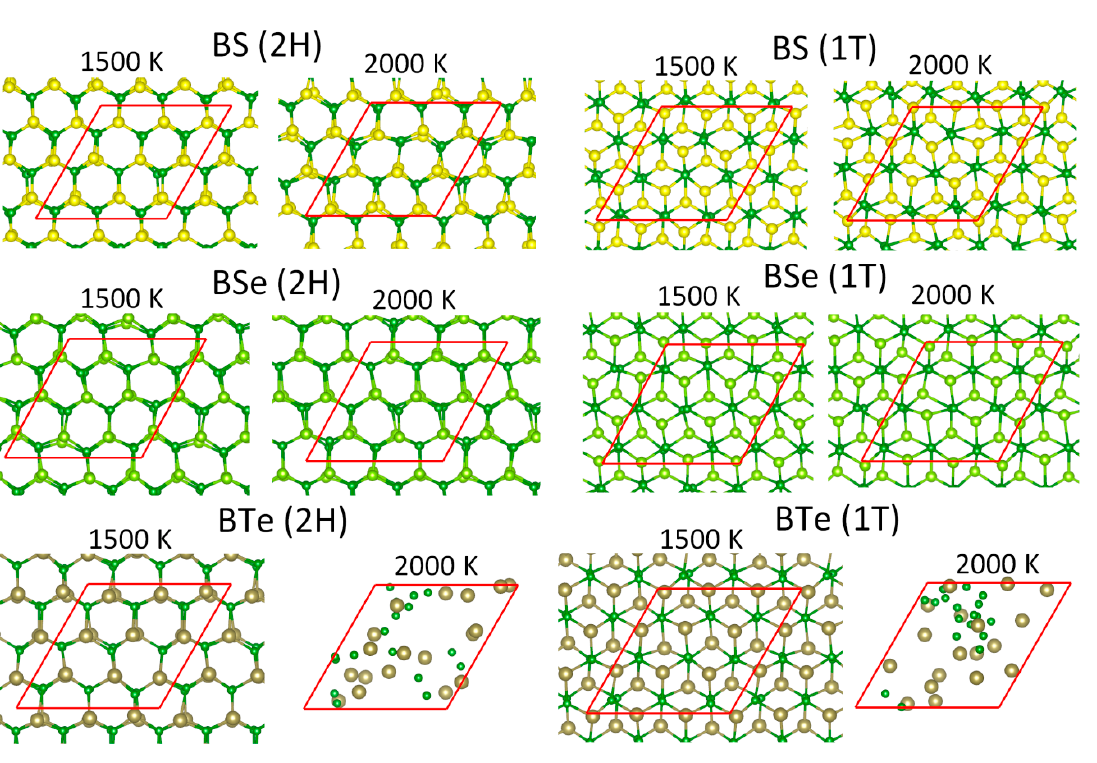
Figure 3. Snapshots of single-layer boron monochalcogenides at different temperatures of 1500 K and 2000 K after the AIMD simulations for 15 ps.